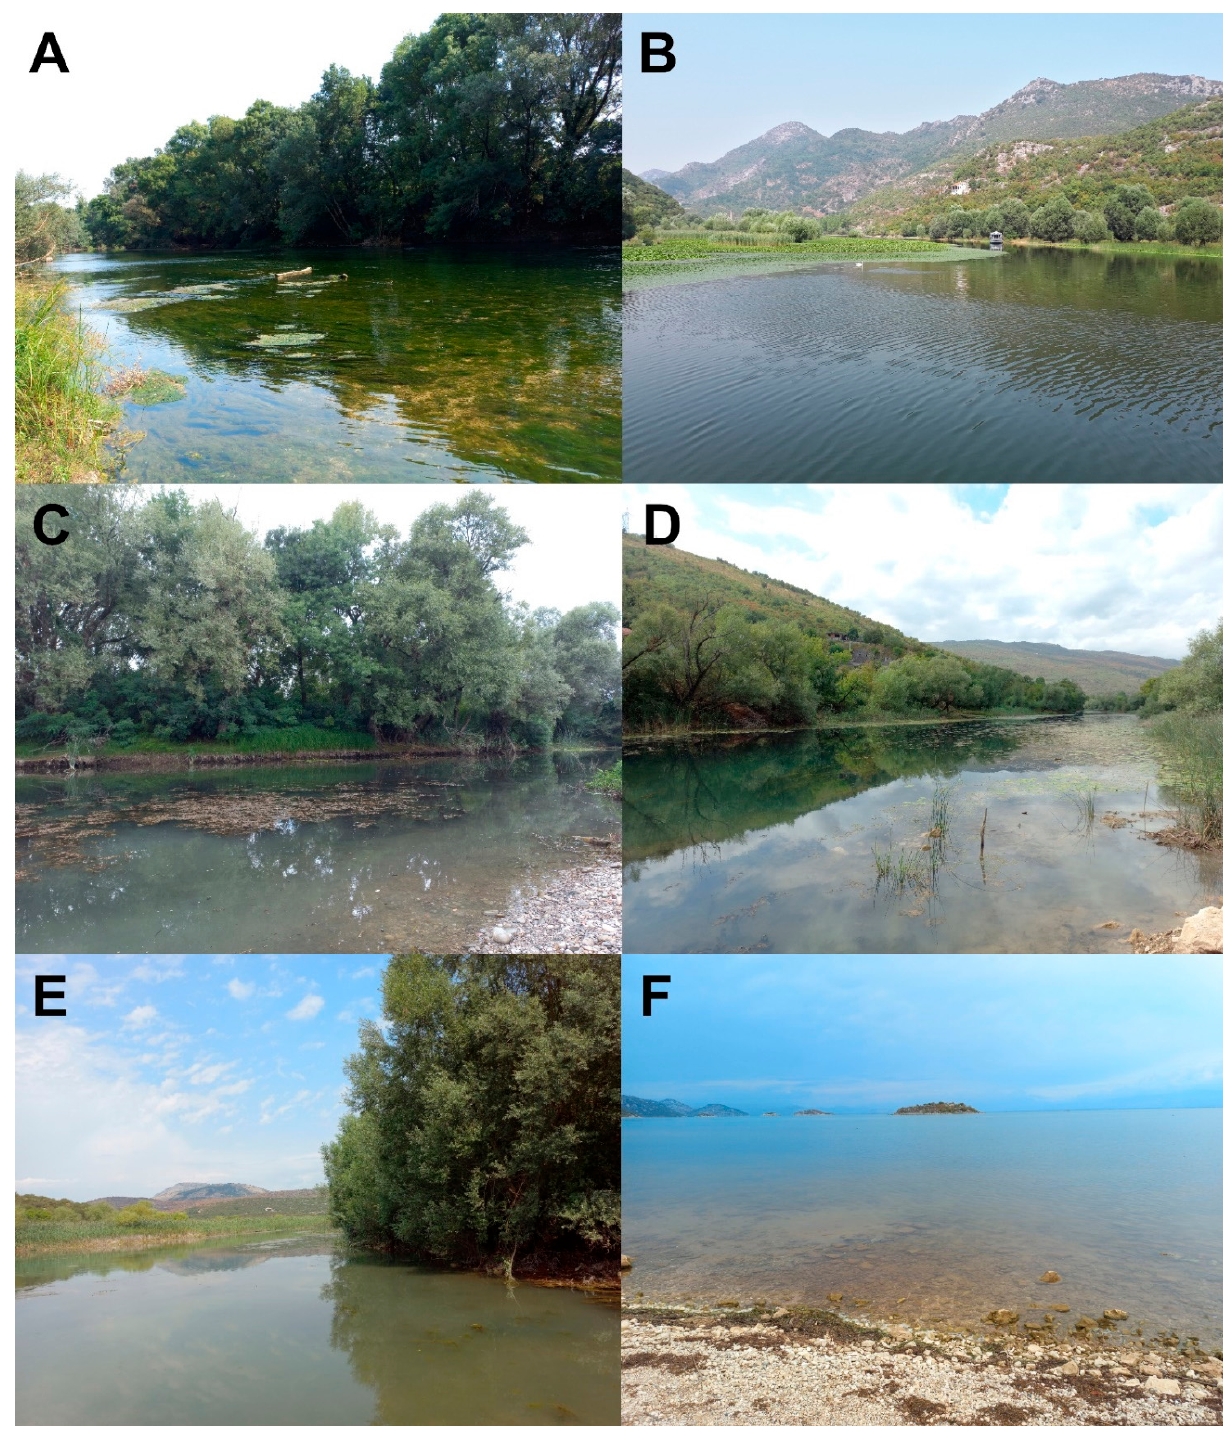
Figure 2. Habitats of freshwater mussels (Unionidae) in Montenegro. ( A ) Zeta River ( Microcondylaea bonellii and Unio carneus stat. rev. ). ( B ) Crnojevica River ( Anodonta exulcerata , Unio carneus stat. rev. , and U. elongatulus ). ( C ) Plavnica River ( A. exulcerata and U. elongatulus ). ( D ) Sitnica River ( A. exulcerata ). ( E ) Skadar Lake (Podhum), site 1 ( A. exulcerata ). ( F ) Skadar Lake (Donji Muri ć i village), site 2 ( U. elongatulus ).